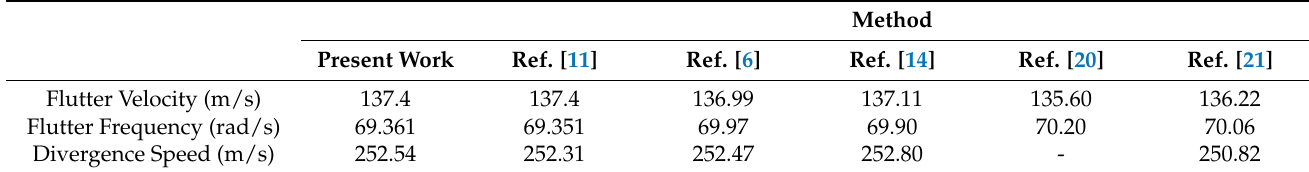
Figure 7. Goland wing flutter modes. Left : Real part of poles vs. Velocity. Right : Frequency vs. Velocity.